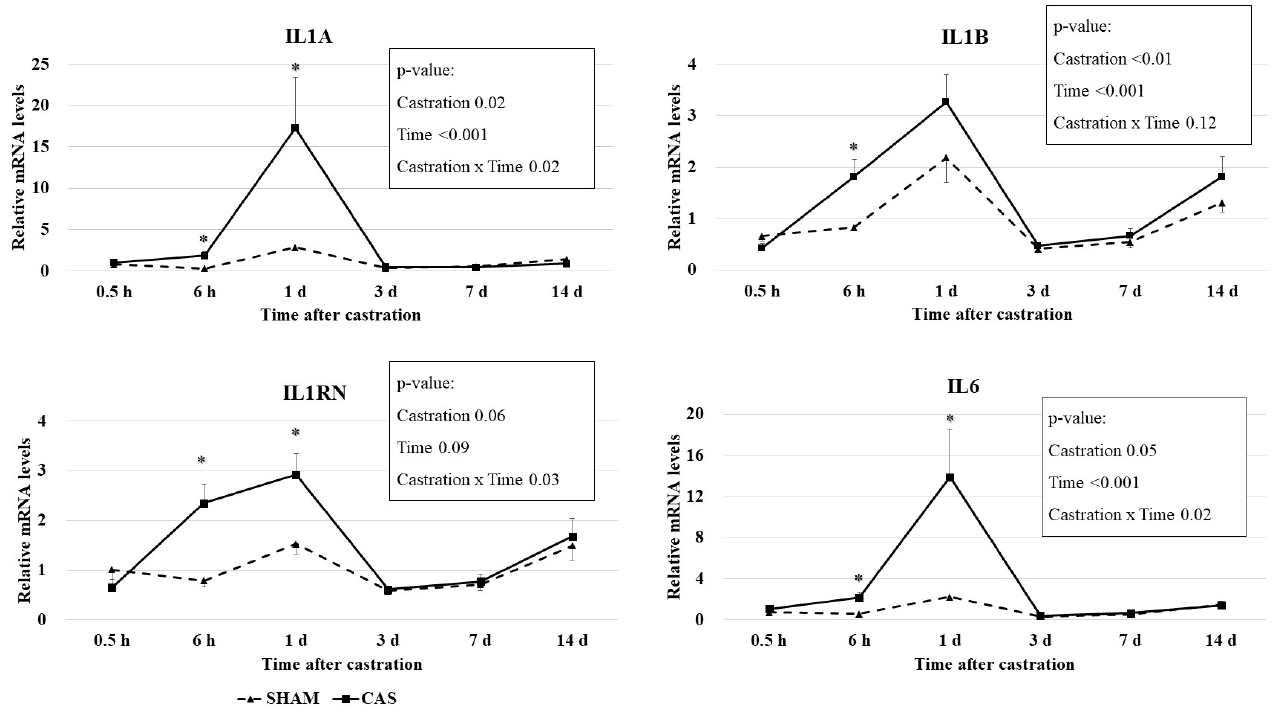
Figure 2. Effect of castration on leukocyte cytokine gene expression in Korean cattle calves. Male calves were allocated into two groups: CAS = castration (n = 10); SHAM = sham (n = 9). Relative gene expression levels were normalized to average mRNA levels of sham groups of all times. IL6, interleukin 6; IL1A, interleukin 1 alpha; IL1B, interleukin 1 beta; IL1RN, interleukin 1 receptor antagonist. The p-values indicate results of two- way repeated measures analysis of variance analysis. An asterisk (*) indicates that the values differ between castration and sham group at each time point (p<0.05,